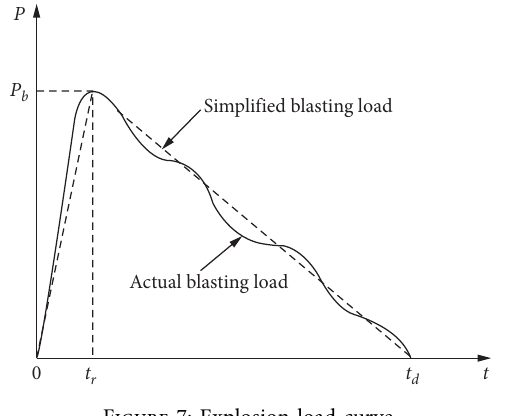
Figure 7: Explosion load